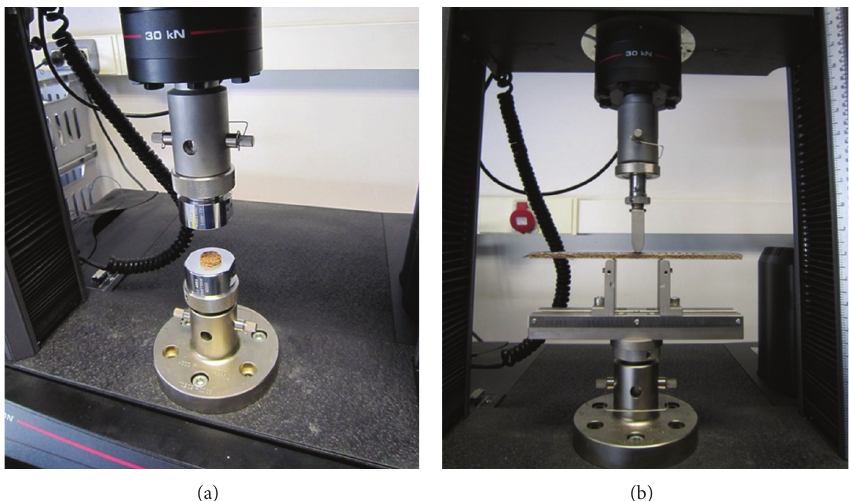
Figure 5: (a) Setup for compression testing of cork. (b) Specimen configuration for flexural testing of the composite sandwich.